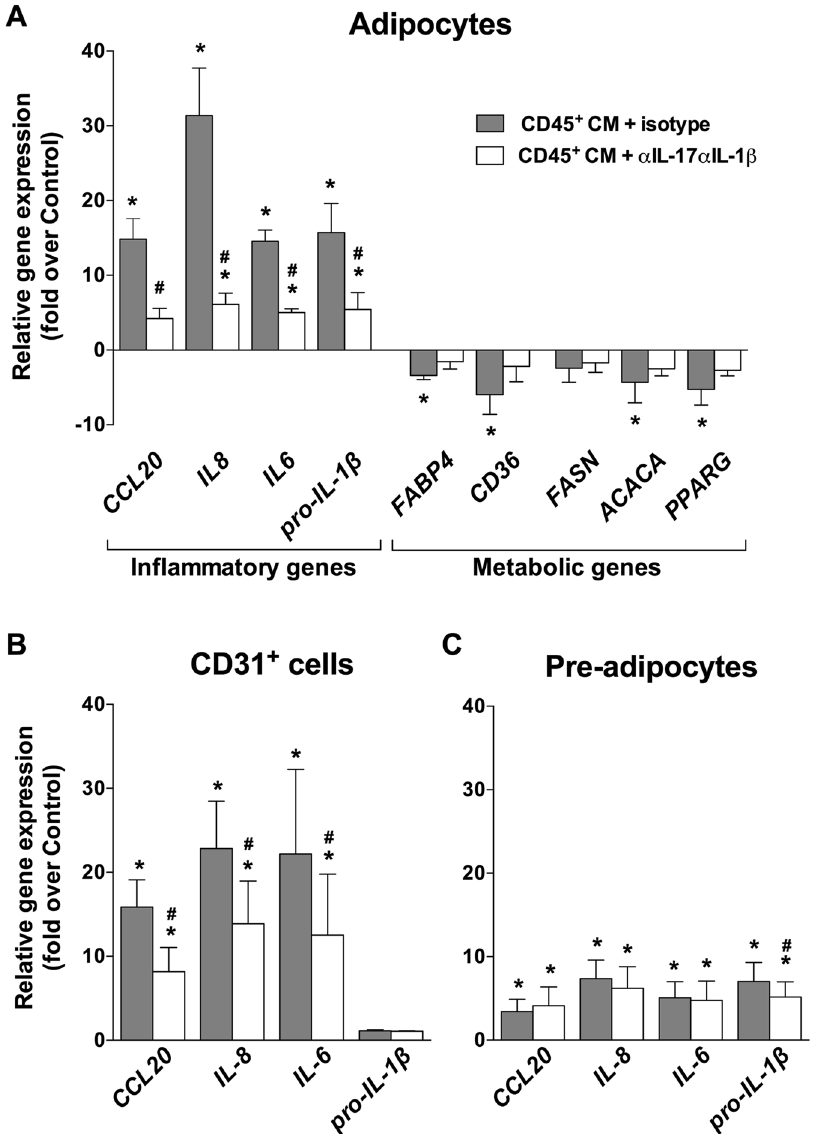
Figure 5. Cell-specific contribution of IL-1 β and IL-17 to inflammatory and metabolic gene regulation. ( A ) Metabolic and inflammatory genes were quantified by QuantiGene Plex in adipocytes (n = 4). Inflammatory gene levels were analyzed by RT-qPCR in ( B ) CD31 + endothelial cells (n = 6) and ( C ) pre-adipocytes (n = 6). Cells were cultured in presence of CD45 + cells conditioned medium (CD45 + CM), with addition of isotype control (grey bars) or anti-IL-17 ( α IL-17) and anti-IL-1 β ( α IL-1 β ) neutralizing (white bars) antibodies. * P < 0.05 versus untreated cells. # P < 0.05 versus CD45 + CM + isotype treated cells. Data are shown as mean ±